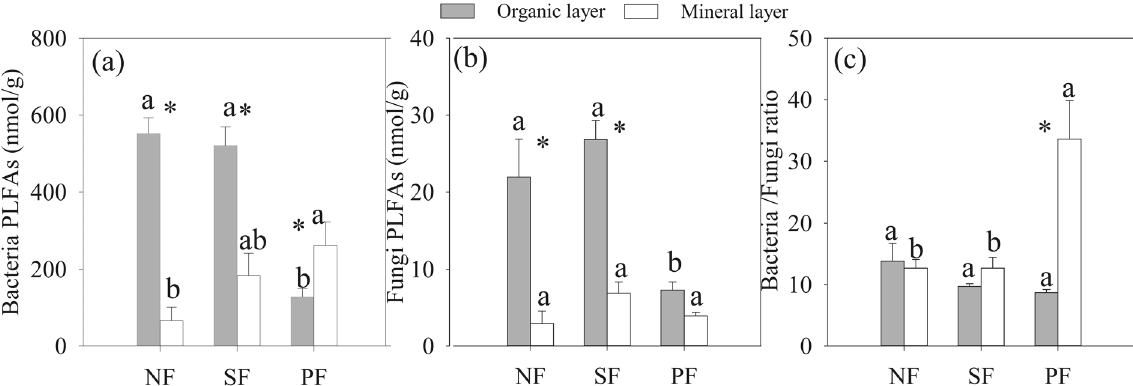
Figure 2. Effects of forest type conversion and soil layer on soil microbial properties. Values indicate means ± SE, n = 4. Different letters within the same soil layer denote significant differences among forest types by one-way ANOVA. Asterisk indicates significant differences between the two soil layers by student t -test. NF: natural forest, SF: secondary forest and PF: spruce plantation.